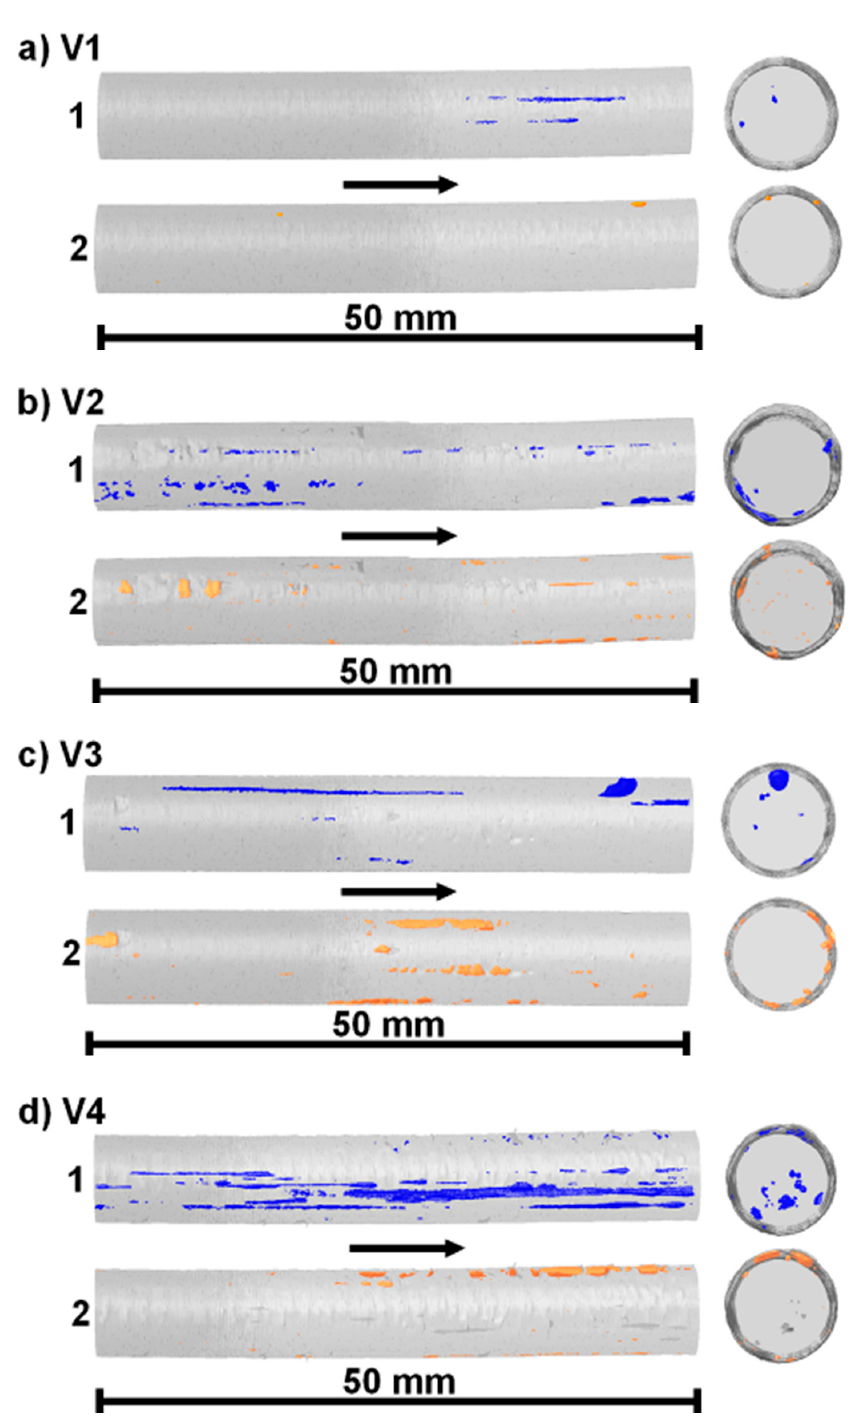
Figure 6. Results of X-ray computer tomography obtained for TiGr4; (1) visualization of detected material having a density less than that of titanium, (2) visualization of detected material having a density higher than that of titanium; ( a ) V1 turning, thin chips, ( b ) V2 turning, coarse chips, ( c ) V3 milling, thin chips, ( d ) V4 milling, coarse chips . The arrow indicates the direction of extrusion.